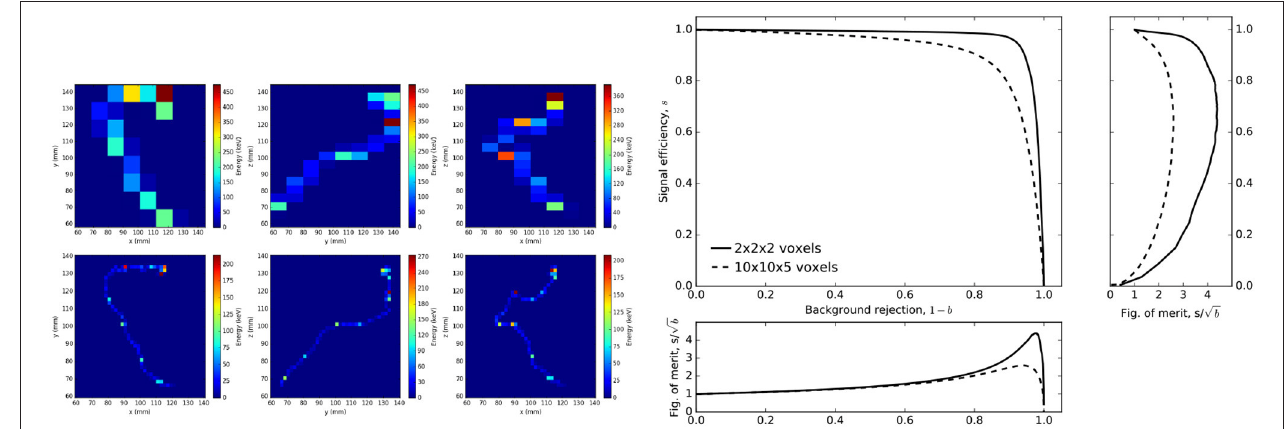
FIGURE 13 | (Left) The three projections of a reconstructed Monte Carlo electron in NEXT-100 (top panels) and NEXT-2.0 (bottom panels). (Right) Signal efficiency vs. background rejection provided by the topological signature in both detectors. See text for details. Reproduced from Renner et al.